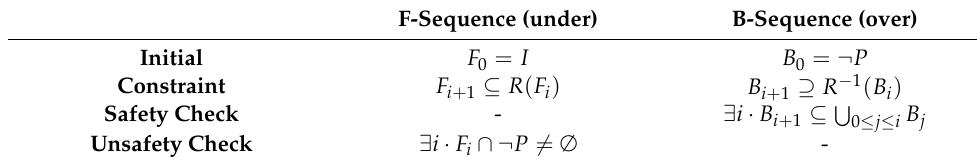
Table 2. The summary of key structures in CAR.